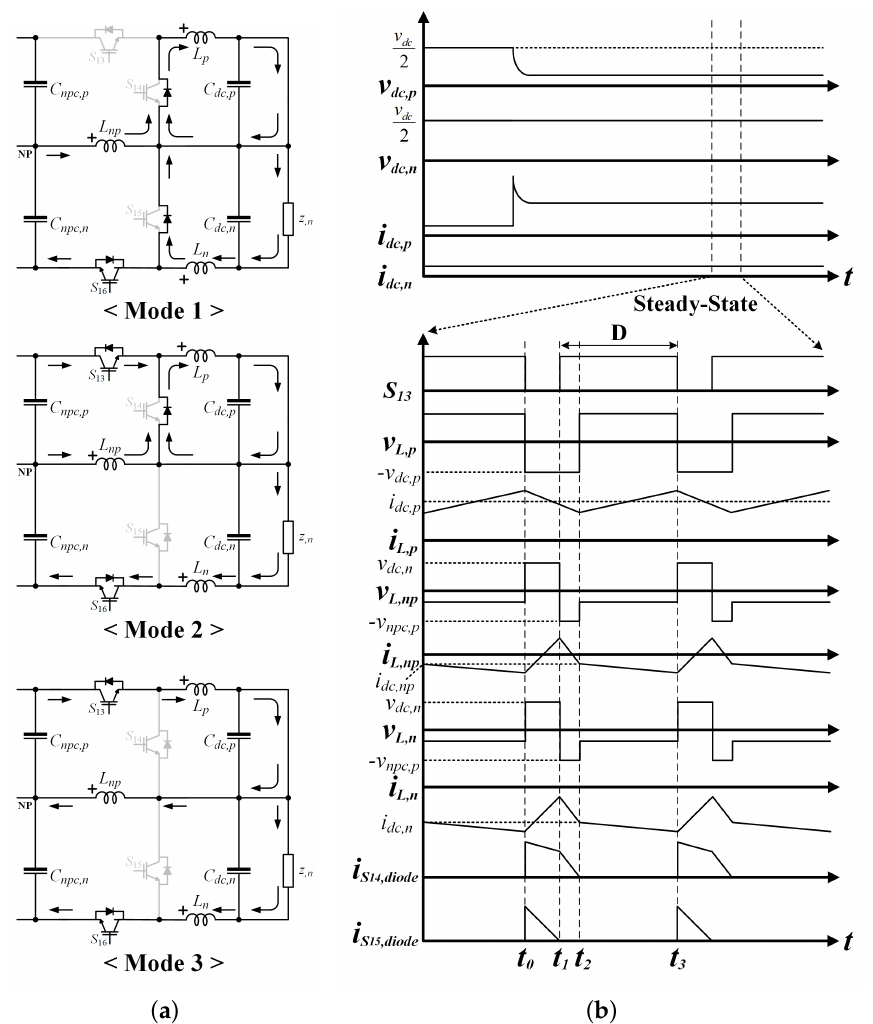
Figure 12. Current limit operation at the short-circuit condition of the positive pole: ( a ) Mode; ( b )